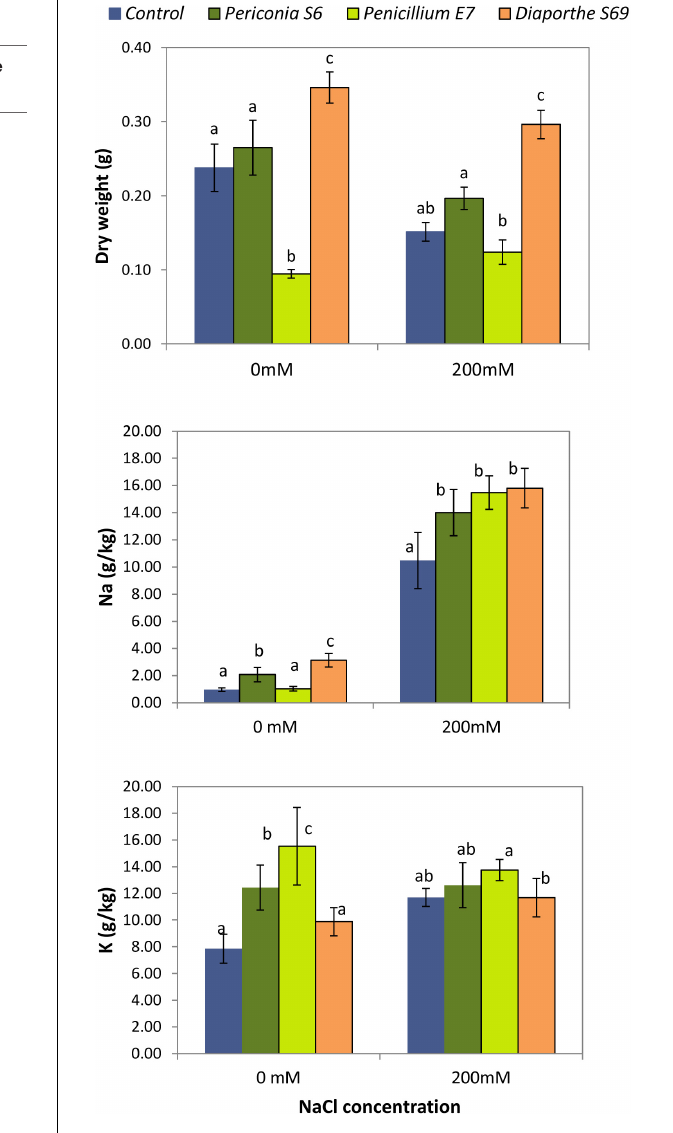
FIGURE 7 | Effect of inoculation with strains Periconia S6, Penicillium E7 and Diaporthe S69, isolated from Festuca rubra subsp. pruinosa, on dry matter production, and Na and K content of Lolium perenne plants watered with 0 mM and 200 mM NaCl. For each NaCl concentration, different letters indicate significantly different means ( p <